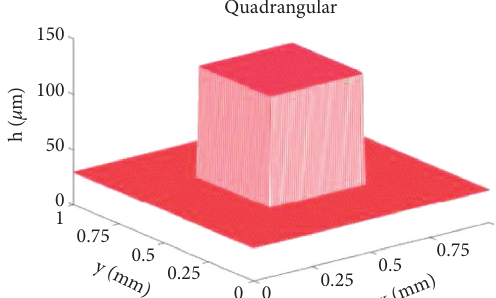
Figure 2: Quadrangular texture oil film gain diagram.